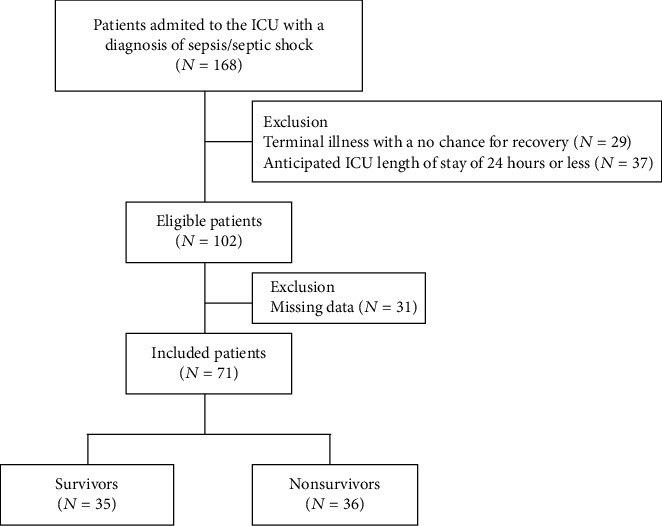
Flow chart of the study.